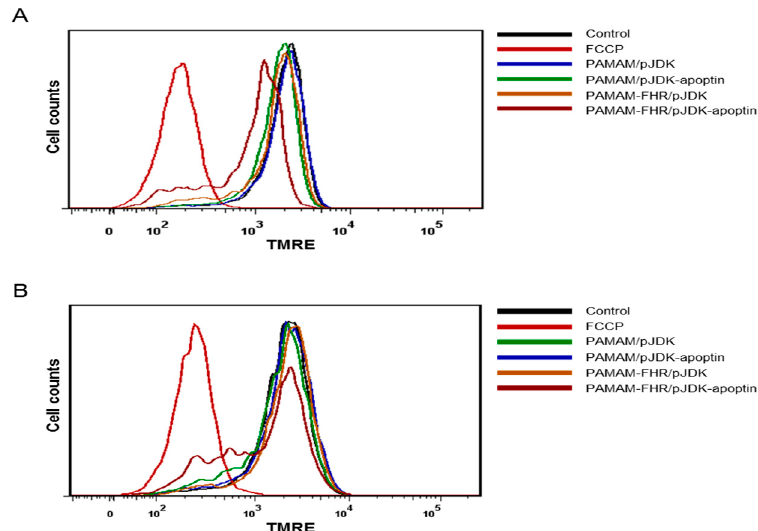
Figure 9. Mitochondrial membrane depolarization by PAMAM-FHR/pJDK-apoptin. ( A ) GBL-14 and ( B ) dermal fibroblasts were incubated with polymer/pJDK or pJDK-apoptin complexes. The cells were analyzed for MMP after TMRE staining and then evaluated by flow cytometry. FCCP was used as a positive control. Results are shown as the mean ± standard deviation, n = 3. MMP, mitochondrial